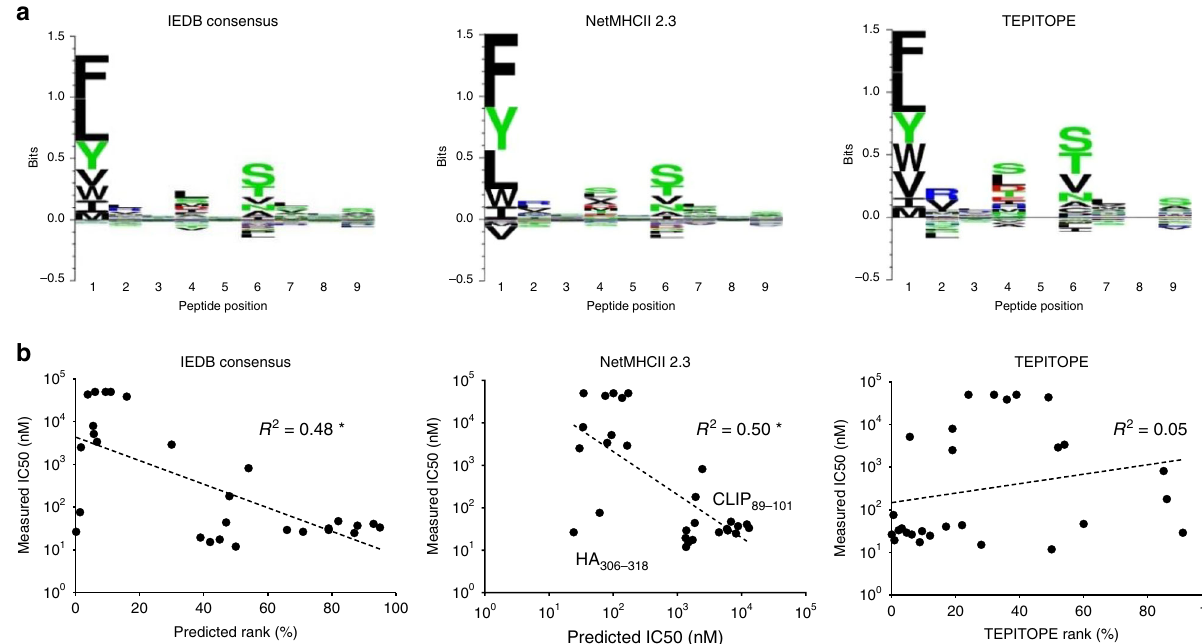
Fig. 3 Comparison of library-enriched HLA-DR401-binding motif to MHC-II prediction algorithms. a Kullback – Leibler relative entropy motifs of the core nine amino acids of HLA-DR401-binding peptides, as determined by application of selected MHC-II prediction algorithms to computationally-generated peptides. b Scatterplots of algorithmic predictions versus measured IC 50 with lines of best fi t and their associated coef fi cients of determination ( R 2 ). Asterisk denotes R 2 values of negative correlations. Source data are provided as a Source Data fi